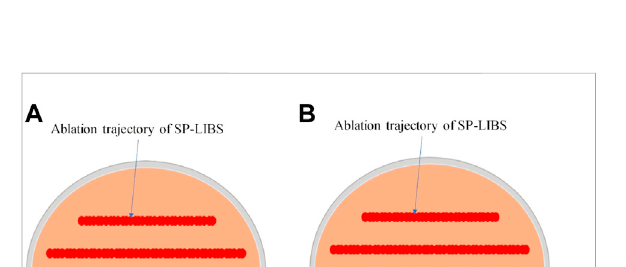
FIGURE 1 System structure diagram.